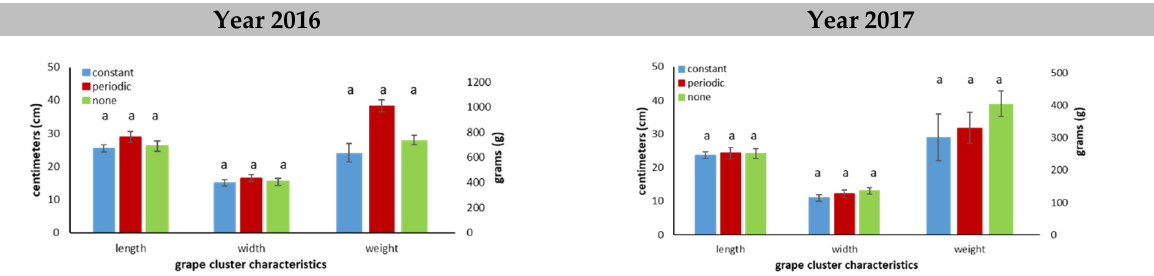
Figure 9. The effect of different wildflower meadow harvest treatments (constant, periodic, or none) on the quantitative characteristics of the grape clusters (mean length, width, and weight) in 2016 and 2017. Within each measurement, statistical differences are denoted by different letters (Tukey HSD, at p < 0.05, n = 12).